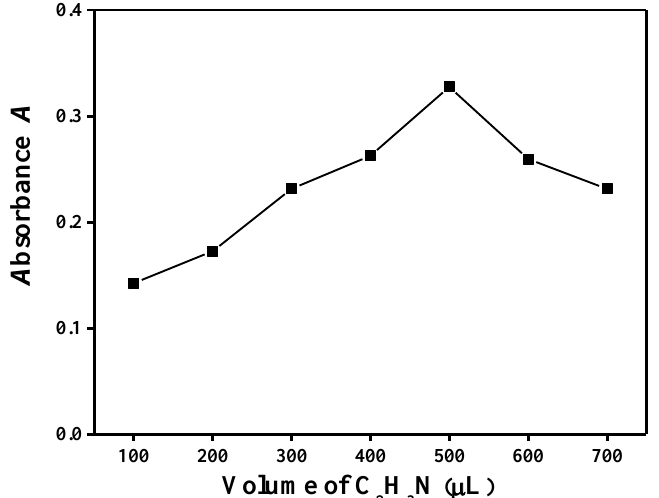
Figure 4. Effect of CH 3 CN volume on the extraction efficiency of Cu(II). Extraction conditions: 5.00 mL water sample, pH = 5.0, 100 µ L 5 × 10 −4 mol/L 5-Br-PADMA, 40 µ L C 6 H 5 Cl, and 0.5 ng Cu.